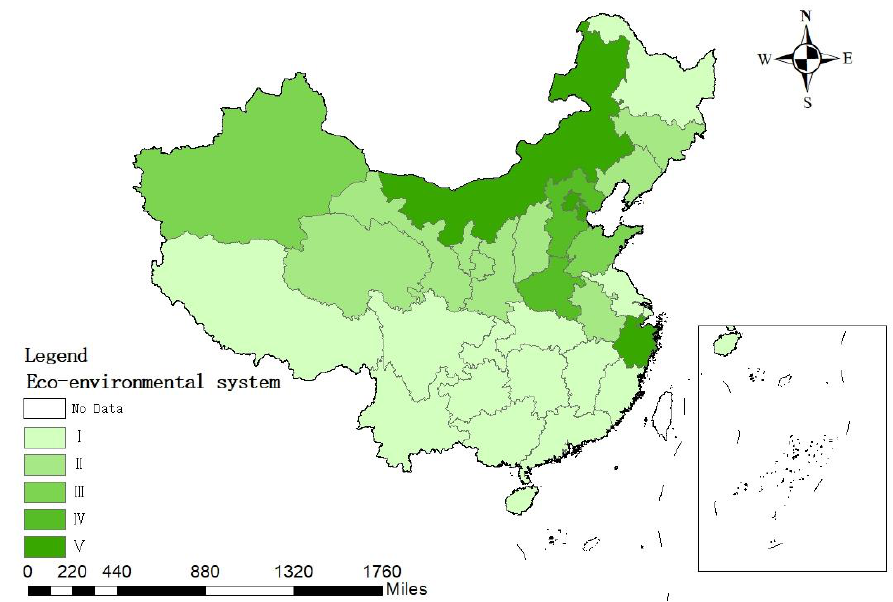
Figure 5. Assessment results of China ’ s eco-environmental subsystem.